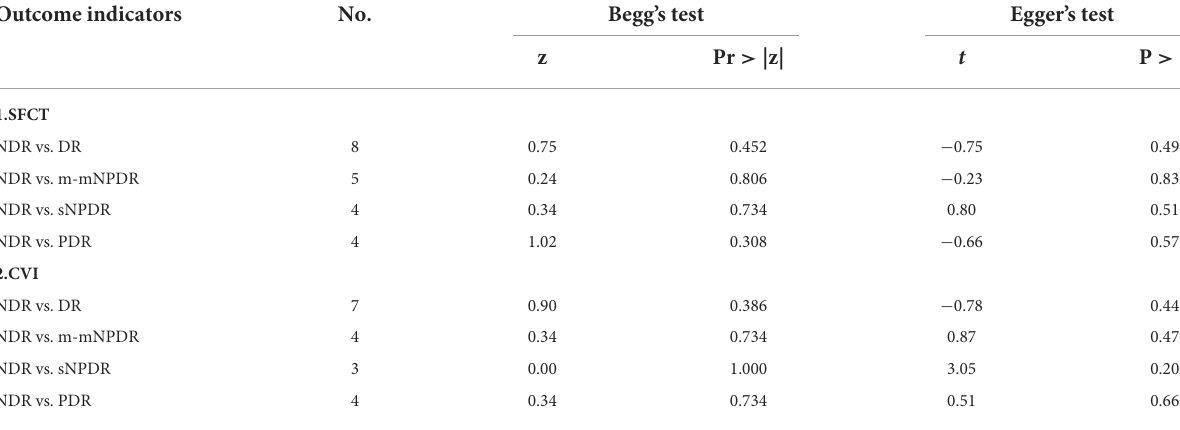
TABLE 5 Begg’s and Egger’s tests results for the evaluation of publication bias. Outcome